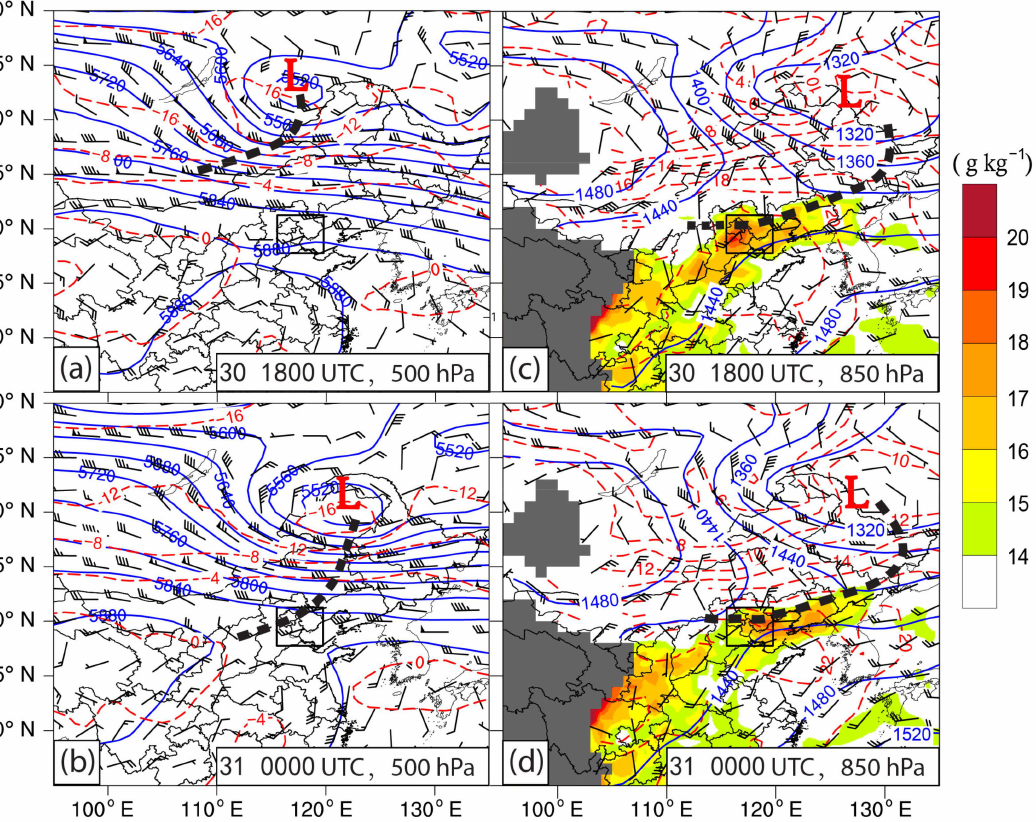
Figure 5. ( a – d ) Geopotential height (blue lines, units: gpm), temperature (red lines, units: ◦ C), and wind fields (half barbs, full barbs, and flags represent 2, 4, and 20 m s − 1 , respectively) derived from NCEP FNL data in July 2010. The specific time and isobaric surface levels are shown in the lower right corner of each panel. The shaded color area in ( c , d ) represent the water vapor mixing ratio (units: g kg − 1 ) in excess of 14 g kg − 1 , the dark gray shadings show the plateau or mountainous area with ground pressure below 850 hPa. The thick black dashed lines indicate the trough, the small rectangle area in all panels denote the study area shown in Figure 1a. The letter “L” indicates the low pressure